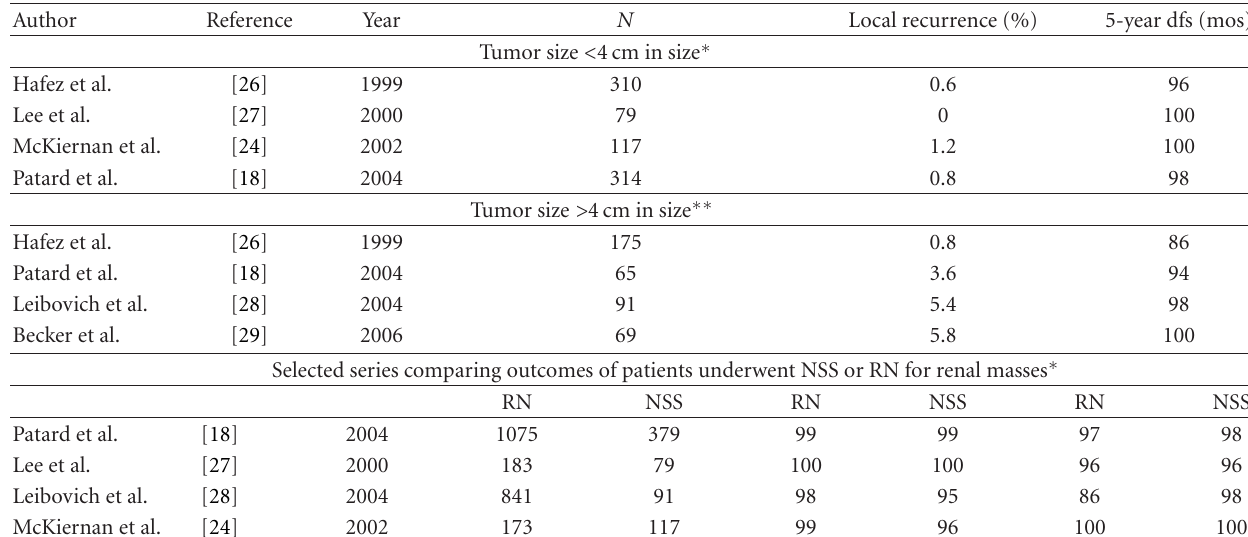
Table 3: Selected published series including patients who underwent open NSS or RN for renal masses due to their tumor size (table modified from [14]).